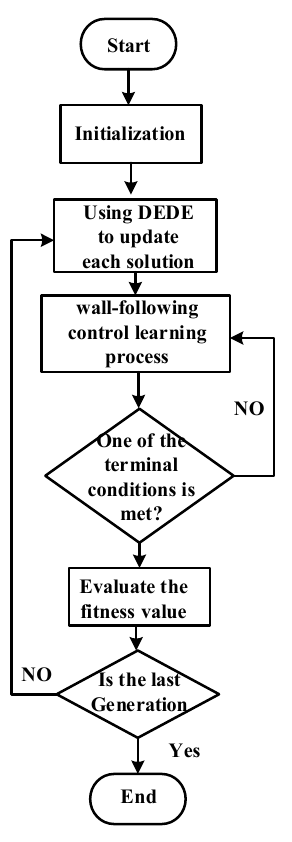
Figure 14. Block diagram of learning process of wall-following control.